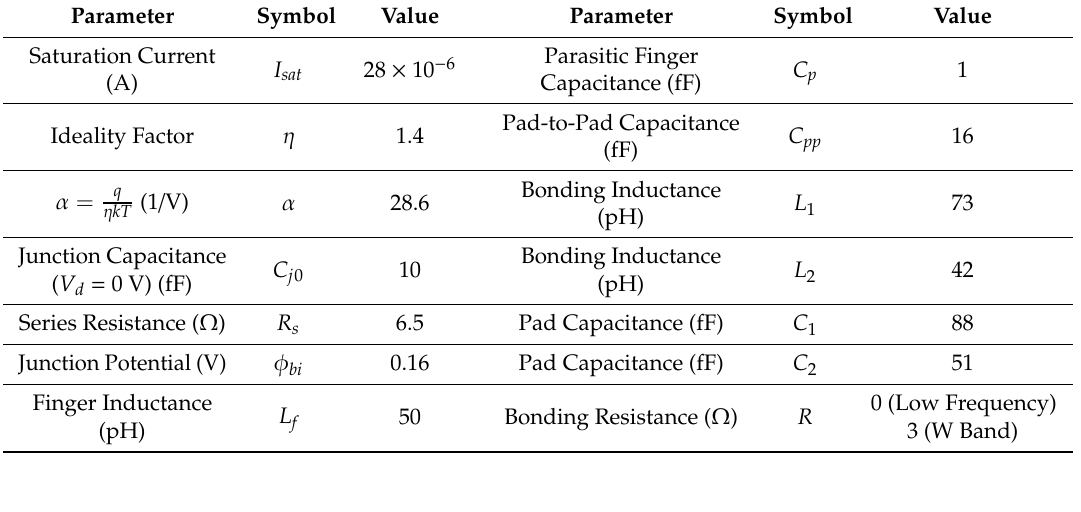
Table 3. Extracted values of the parameters for the ZBD model.